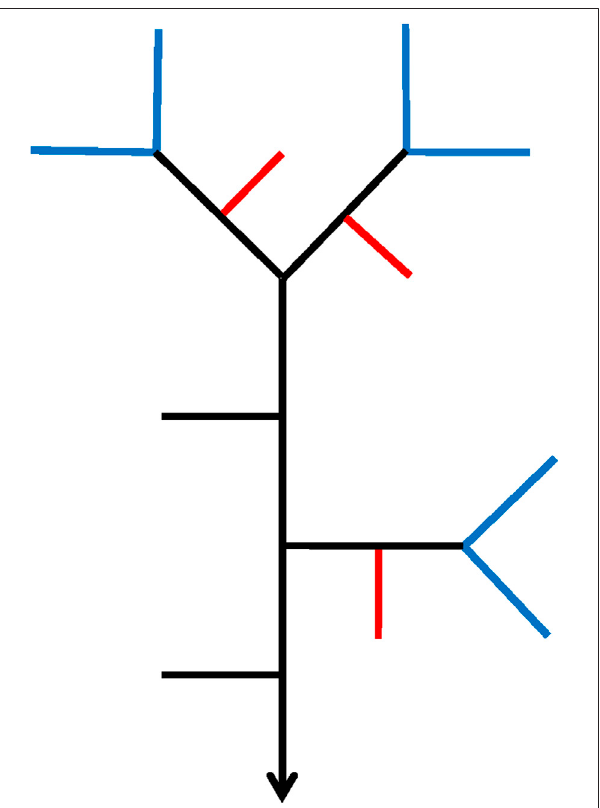
FIGURE6| TheQU-IBTNgeneratedby λ i (cid:2) 1, λ o (cid:2) 2, t (cid:2) 2 atthesecond step.TheredlinesarethestreamswithTokunagaorder(1,2)andthebluelines are the sources, which are the streams with Tokunaga order